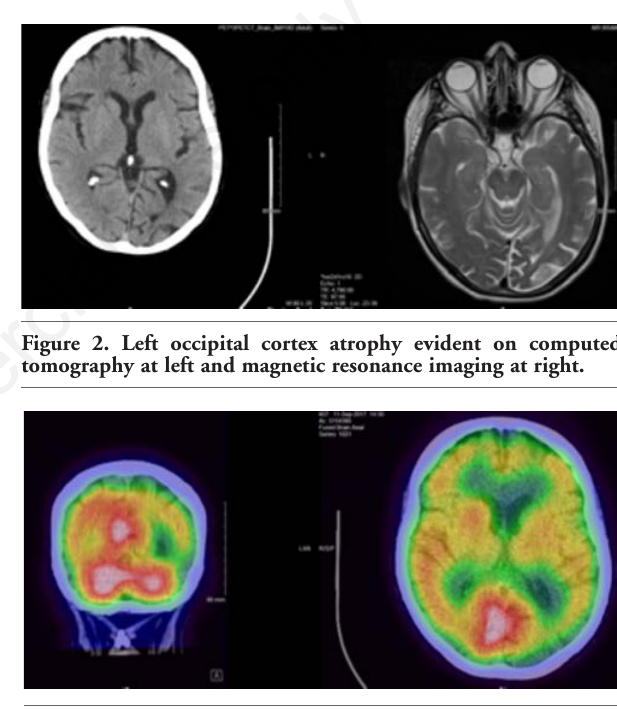
Figure 3. Left posterior parietal hypo-perfusion, characteristic to Alzheimer’s disease with associated marked reduction in perfu- sion to the primary visual cortex as shown for the coronal view through the occipital pole at left and on the axial view at right.